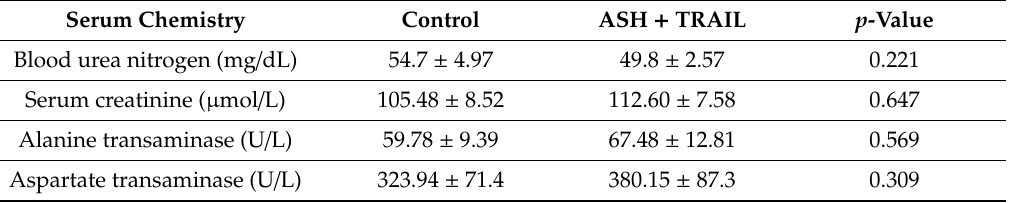
Table 2. The e ff ects of ASH + TRAIL on kidney and liver functions in mice. Table 2. The effects of ASH+TRAIL on kidney and liver functions in mice. Serum